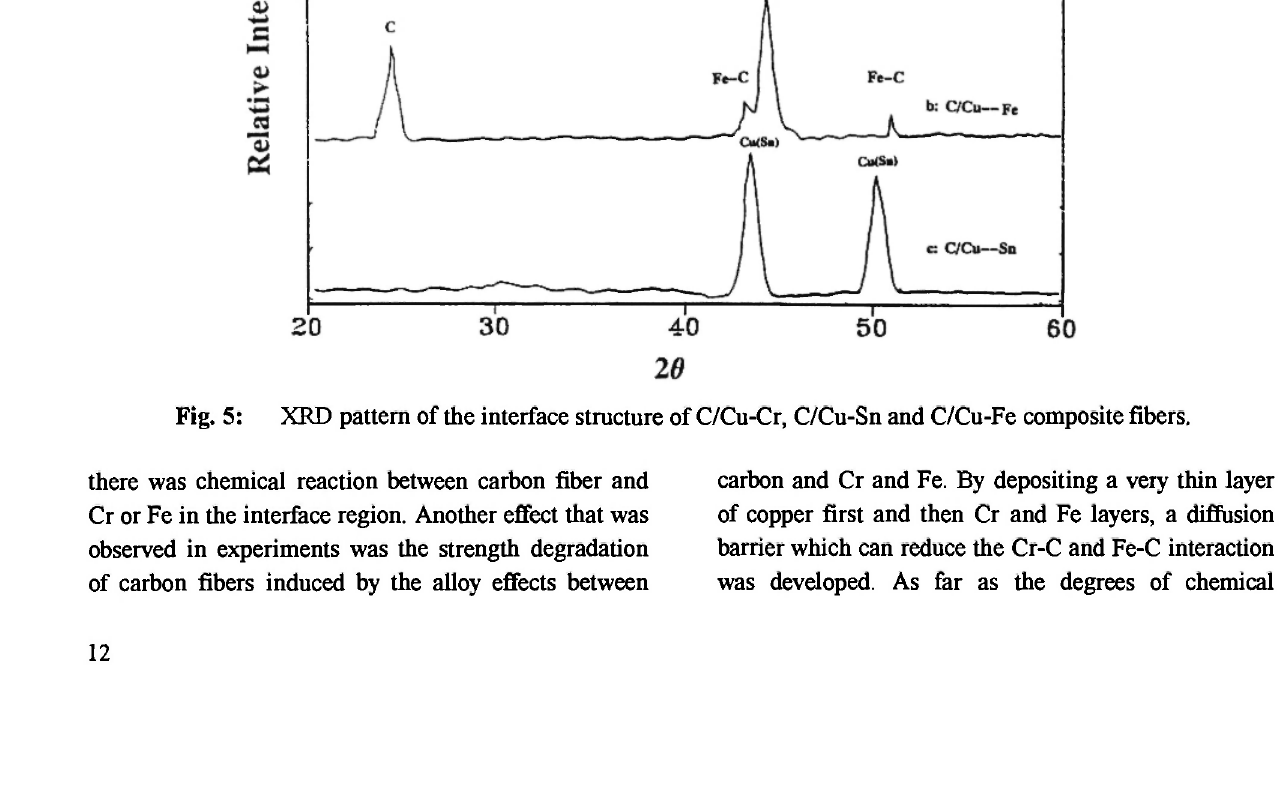
Fig. 4: Temperature dependence of σ τ/σο values of hot-treated C/Cu, C/Cu-Cr, C/Cu-Fe and C/Cu-Sn composite Η fibers.